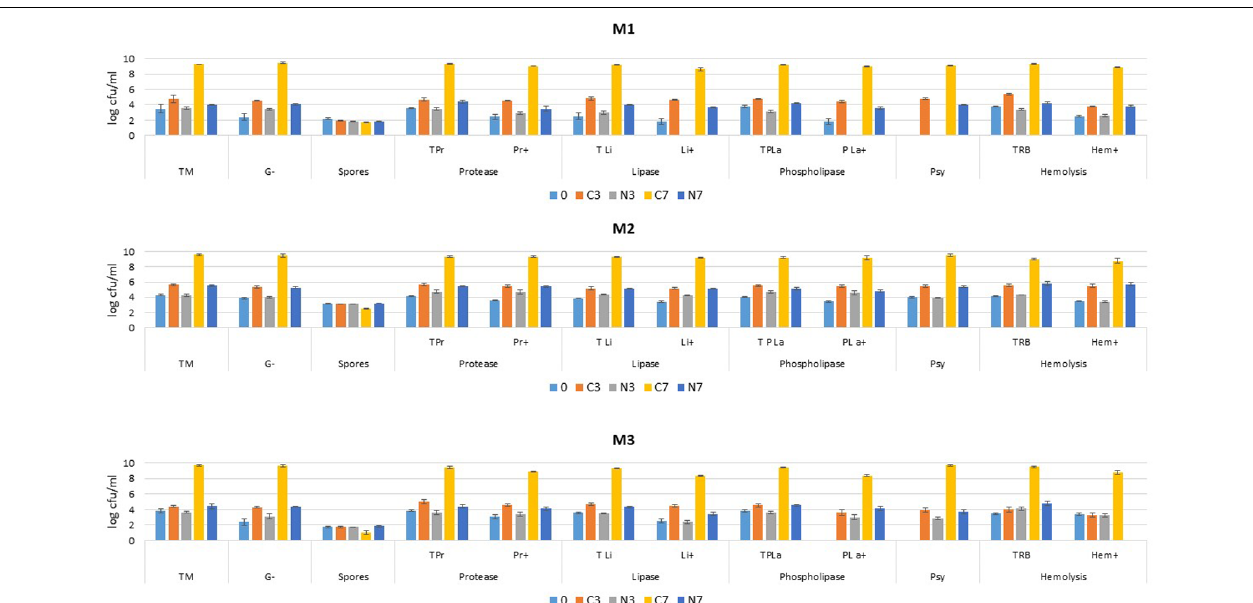
FIGURE 1 | Bacterial counts (log cfu/ml) in bovine raw milk samples (M1, M2, and M3) determined at the initial stage (0) and after cold storage at 6 ◦ C for 3 and 7 days (C3, C7) or in cold-stored while N 2 -flushed samples for 3 and 7 days (N3, N7). The bars correspond to standard deviations. TM, “total counts” on PCA; G-,